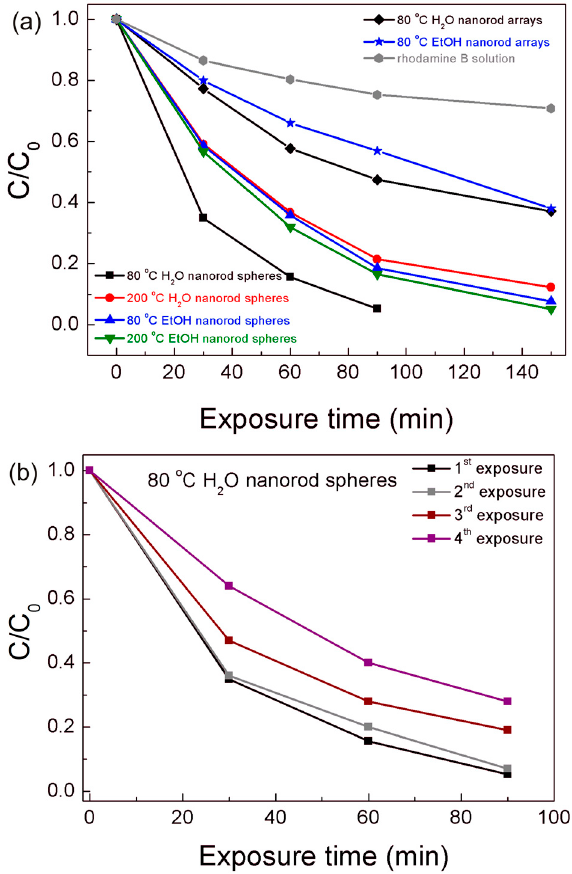
Figure 7. ( a ) Rhodamine B degradation ratio ( C / C 0 ) vs. UV exposure time for all the materials produced. ( b ) Rhodamine B degradation ratio ( C / C 0 ) vs. UV exposure time for the 80 °C H 2 O nanorod spheres after several UV exposure experiments to attest the reusability of the material. The blank rhodamine B solution was simultaneously exposed during the degradation experiments.